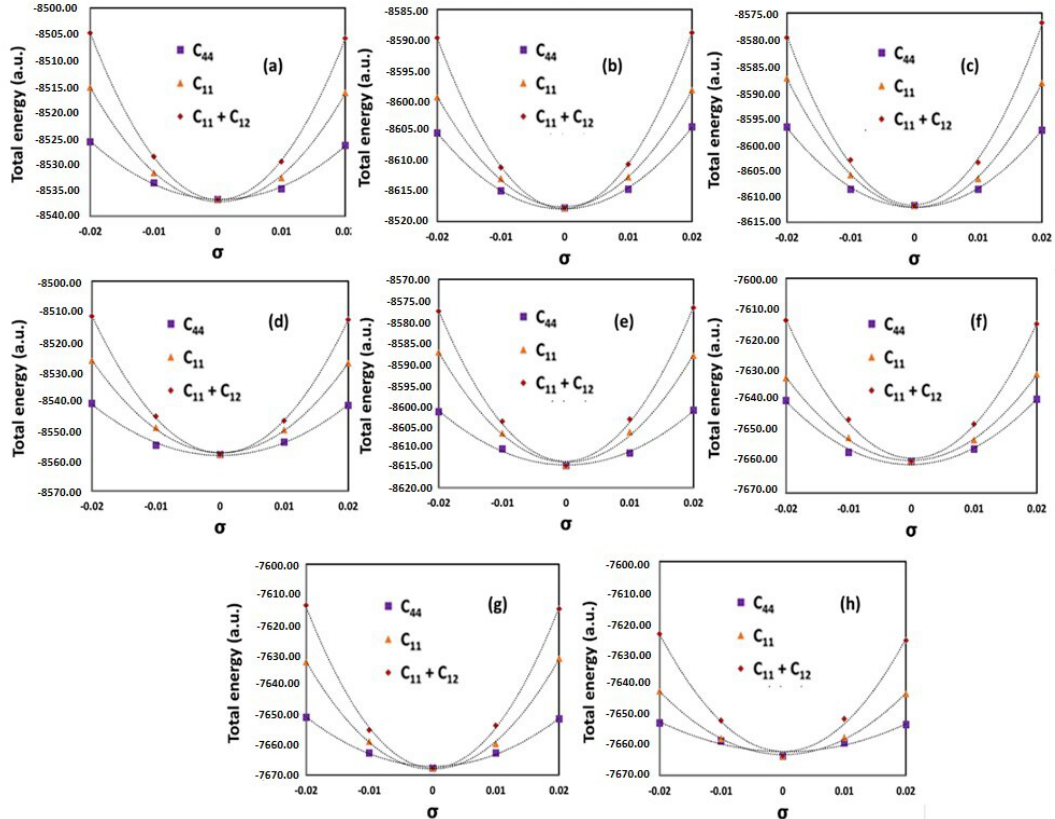
Figure 4. Plots showing energy changes due to application of strains (deformation) and its impact on the elastics constants C 44 , C 11 & C 11 + C 22 for ( a ) AlCoCr 1.3 FeNi 1.3 ( b ) AlCoCrFeNi 1.3 ( c ) AlCoCrFeNiTi 0.9 ( d ) AlCo0 .8 CrFeNiTi ( e ) AlCo 0.9 CrFeNiMn 0.9 ( f ) AlCoFeNiZn 0.85 ( g ) AlCrFeNiMo 0.1 ( h ) AlCoCrFeMo 0.1 .